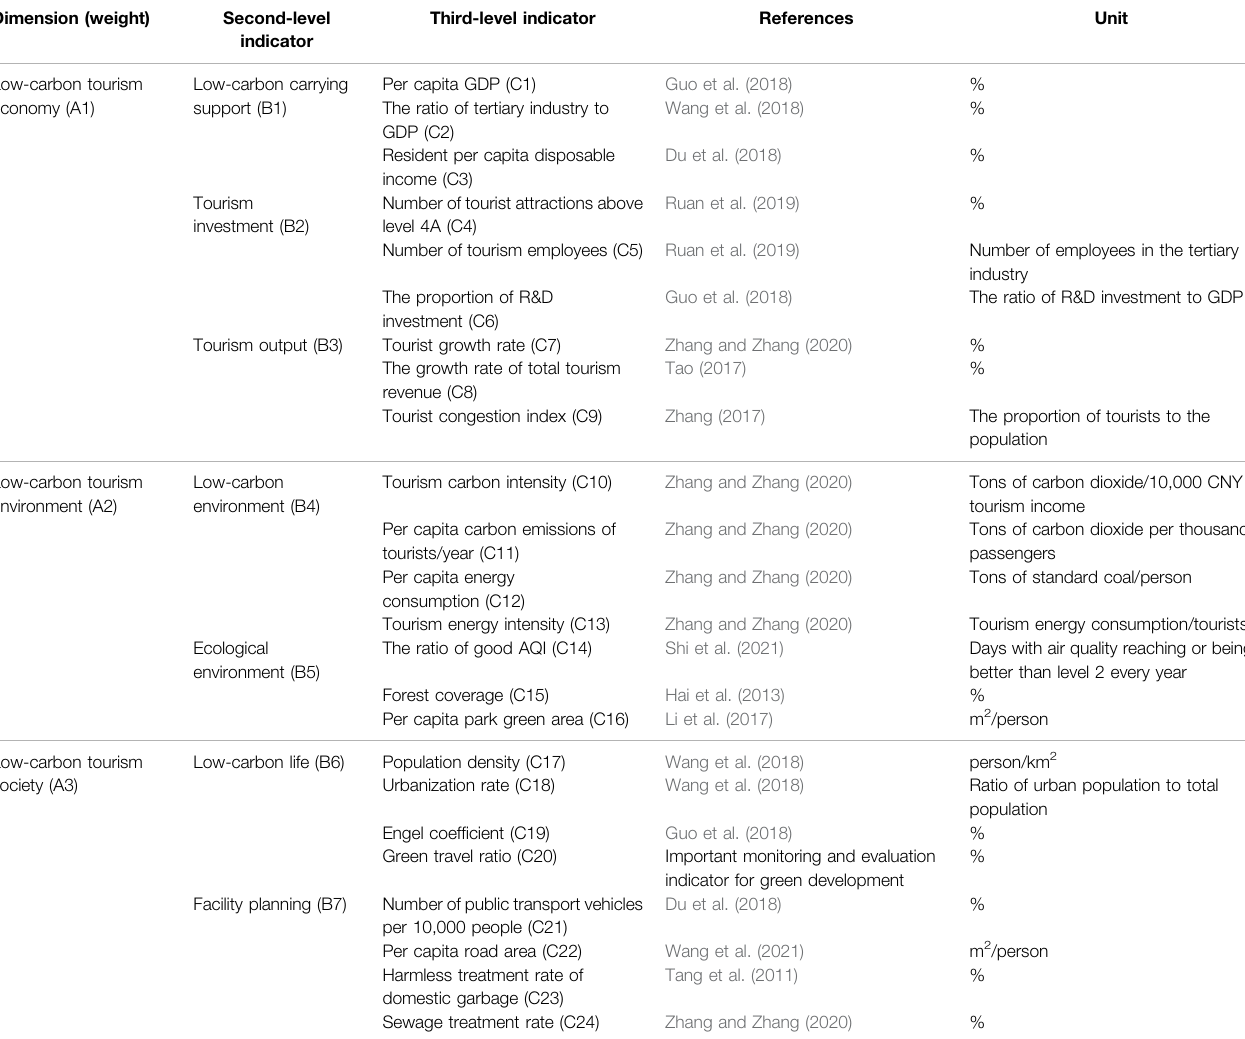
TABLE 4 | Low-carbon city tourism evaluation indicators.